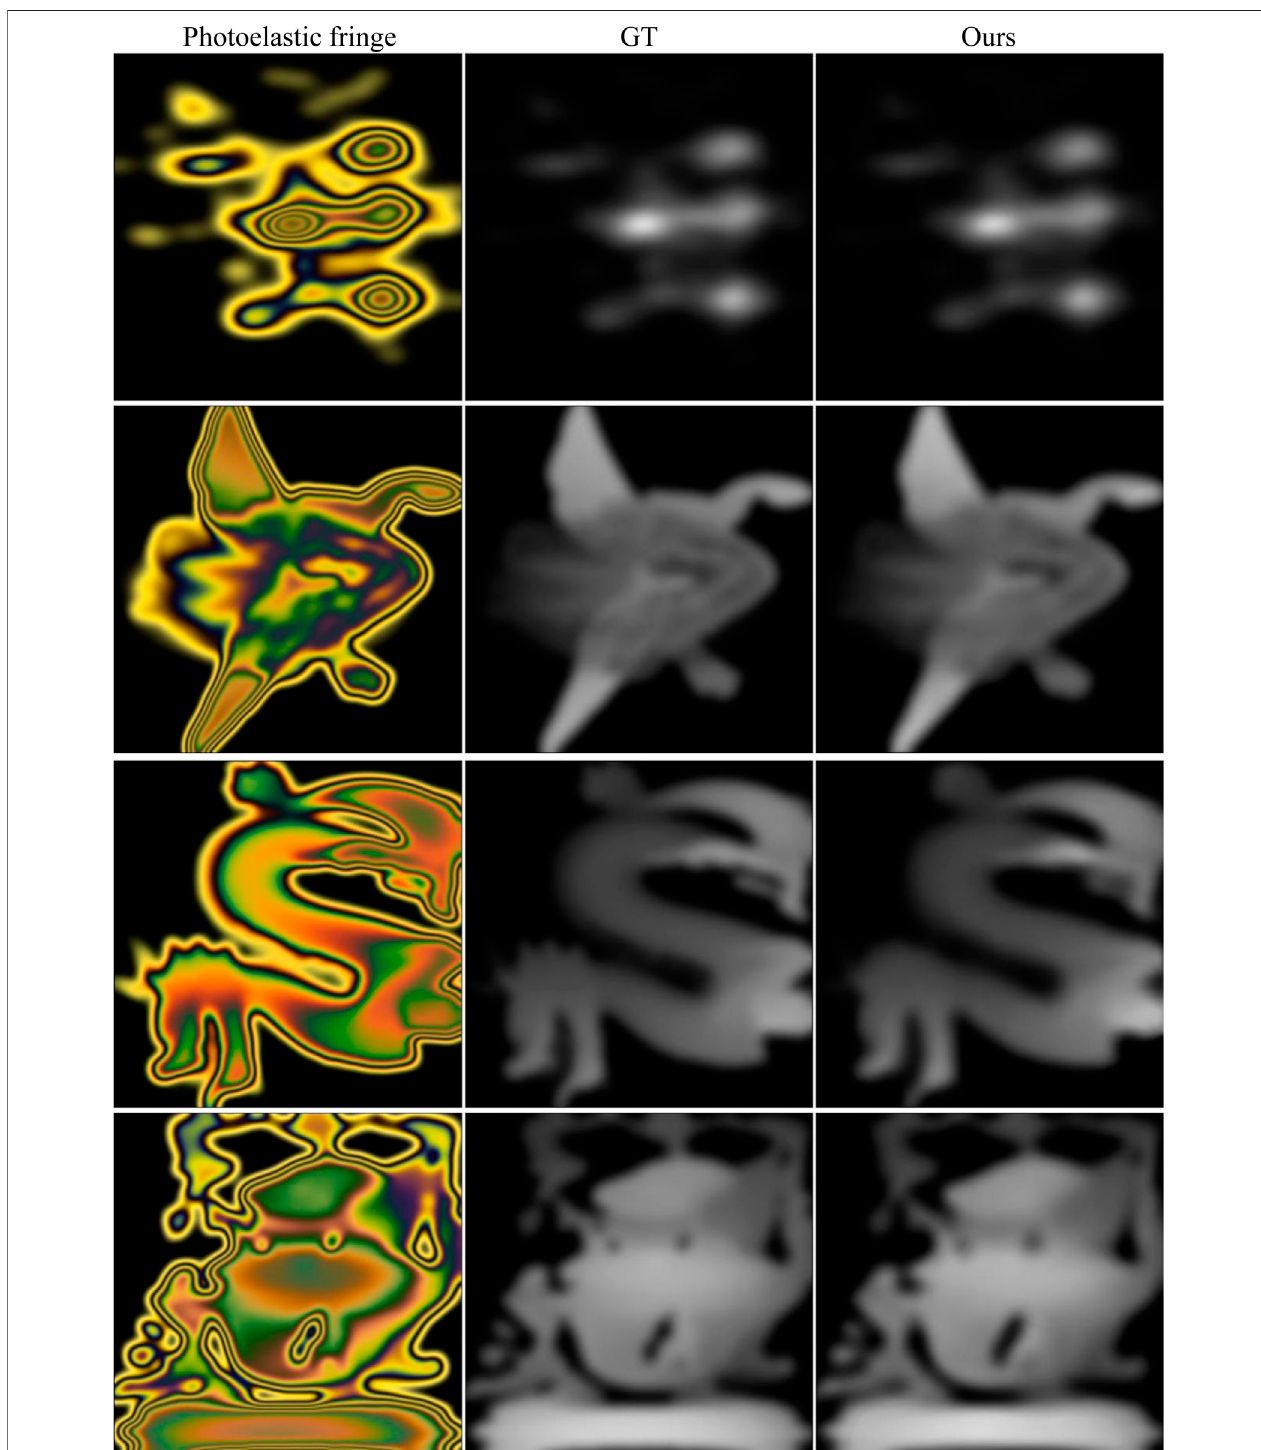
FIGURE 10 | Stress recovery results of complex fringe patterns. First column: photoelastic color fringe pattern; second column: ground truth; third column: predicted stressmap. All fringe patterns and correspondingstressmaps are selected from thetest set (Briñez-de León et al., 2020e).Themaximum stressvalues ofthe ground truth from top to bottom are 72, 48, 48, and 60 MPa.